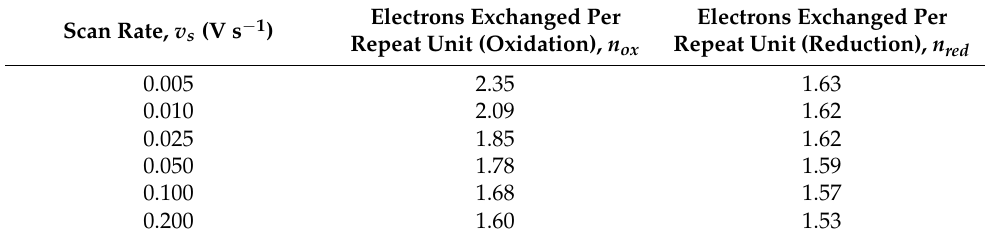
Table 2. Oxidation state of poly-[NiAmben] during voltammetric oxidation/reduction in 0.05 M Et 4 NBF 4